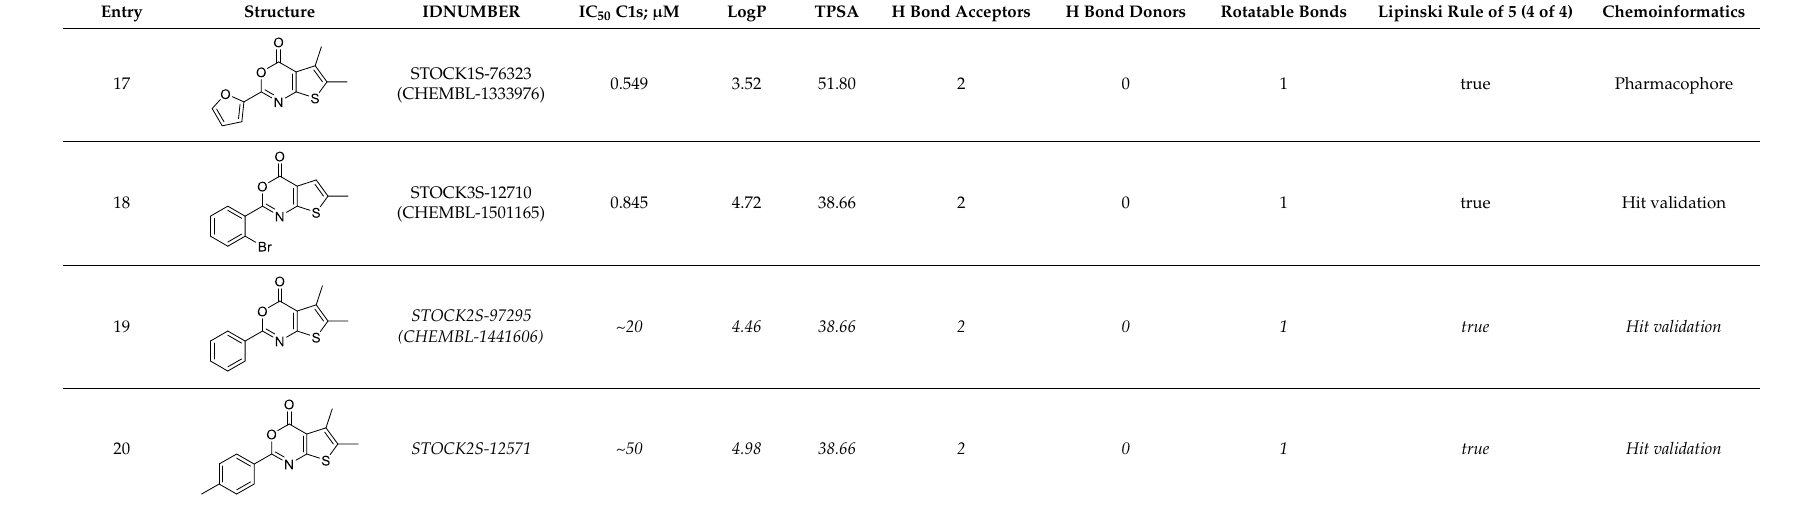
Table 4. Hit compounds derived from the thieno[2,3- d ][1,3]oxazin-4-one chemotype.